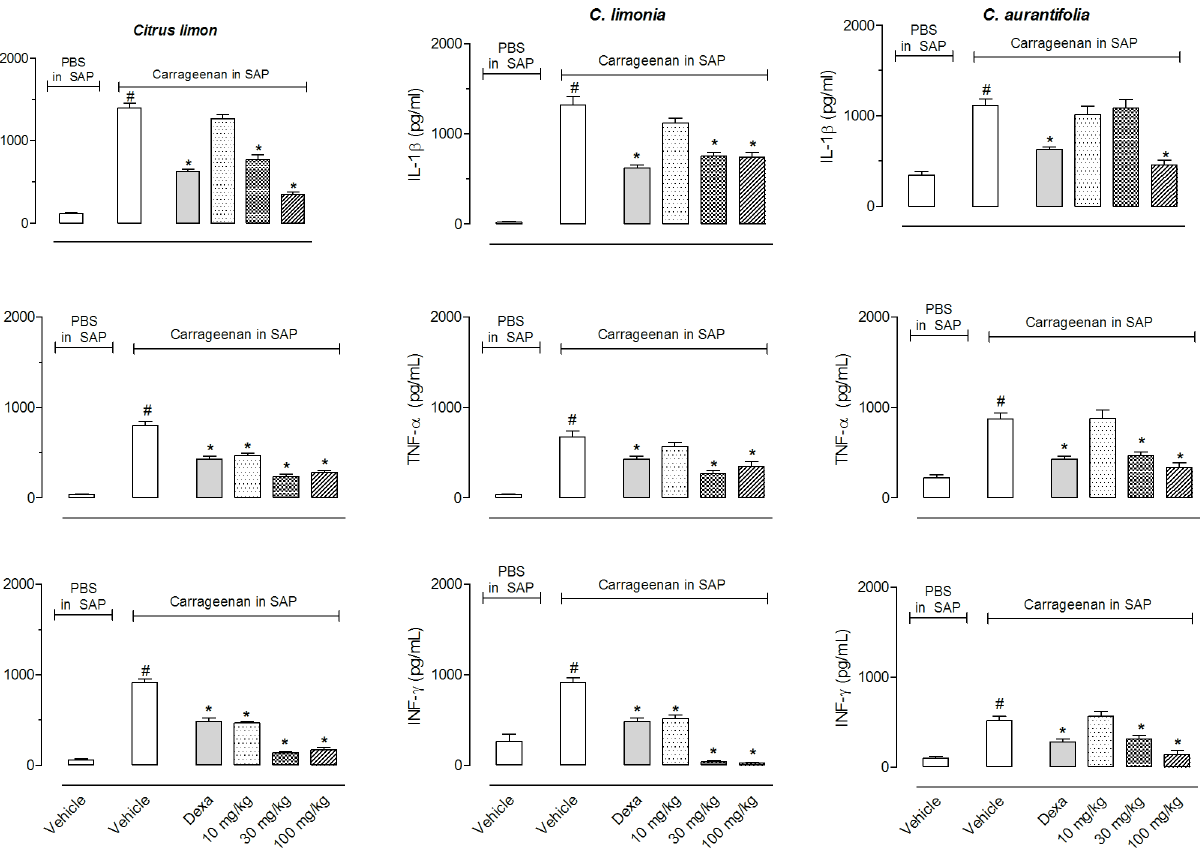
Fig 5. Effects of C . limon , C . aurantifolia and C . limonia essential oils on carrageenan-induced IL-1 β , TNF- α and IFN- γ production in a subcutaneous air pouch (SAP). Animals were pre-treated with various doses (10, 30 or 100 mg/kg, p.o.) of EO, dexamethasone (5 mg/kg, i.p.) or vehicle. The results are presented as the mean ± S.D. (n = 10 per group). Statistical significance was calculated by ANOVA followed by Bonferroni ’ s test. # P < 0.05 when comparing the carrageenan-injected group with the PBS-injected group and * P < 0.05 when comparing EO or dexamethasone-treated groups with the vehicle-treated